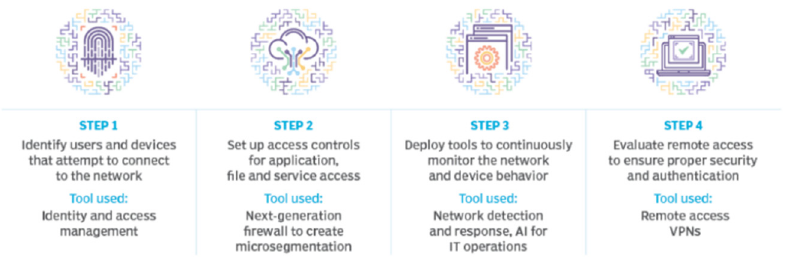
Figure 8. High-level steps involved in designing a zero-trust model for the manufacturing environ- ment.